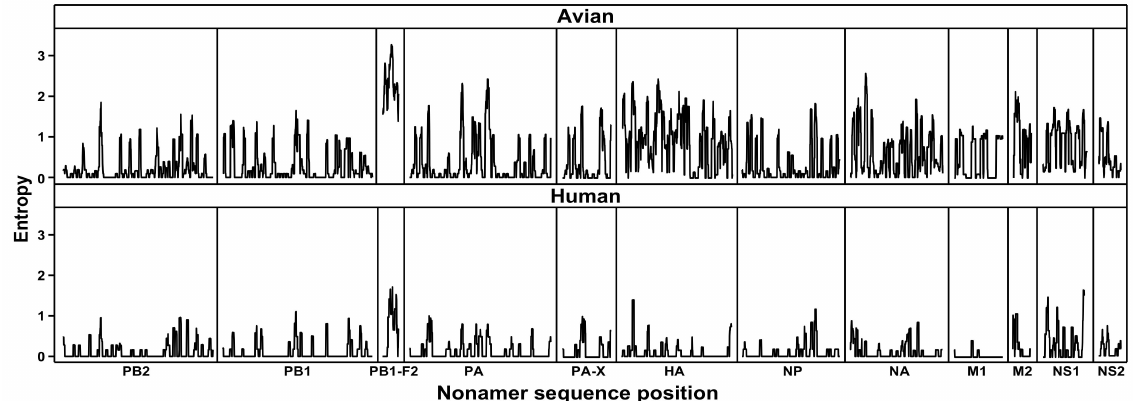
Figure 1. Protein sequence diversity of avian and human influenza A (H7N9) viruses. Shannon’s entropy was used as a general measure of protein sequence diversity for each aligned nonamer (nine amino acids) position of the H7N9 avian (upper) and human (lower) virus proteomes. The entropy values indicate the level of variability at the corresponding nonamer positions, with a zero representing completely conserved sites and high entropy values of about 3 or higher marking highly variable